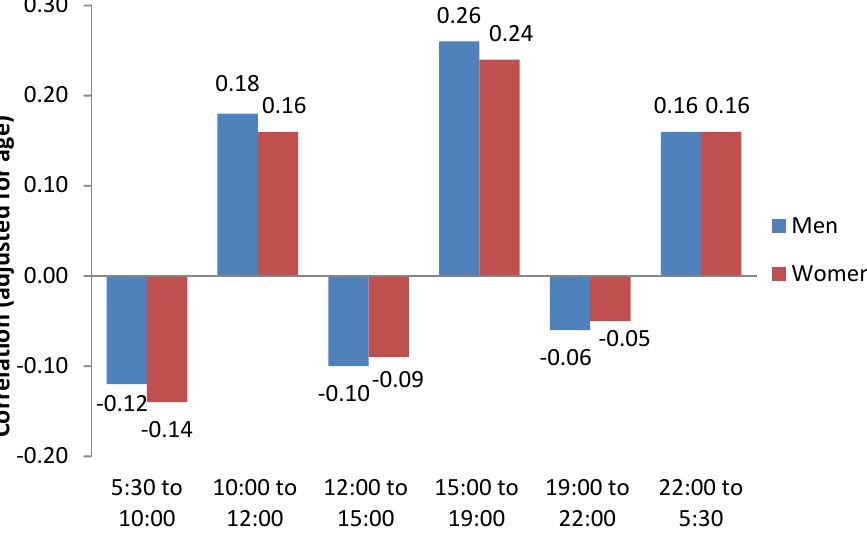
Figure 4. Partial correlations between TWI and beverage consumption in each period, by gender, adjusted for age. Beverage consumption in each period expressed as a percentage of total consumption over 24 h.